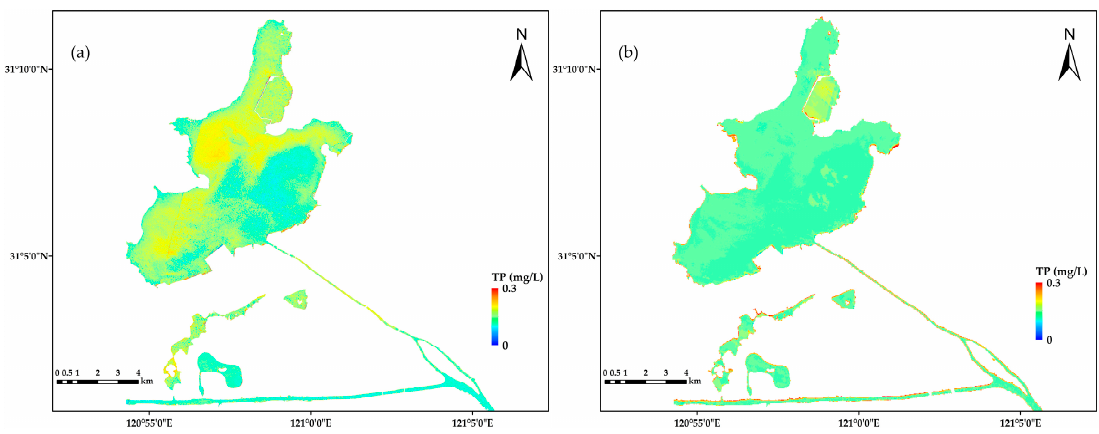
Figure 14. TP maps derived from ( a ) Sentinel-2 and ( b ) ZY1-02D images.